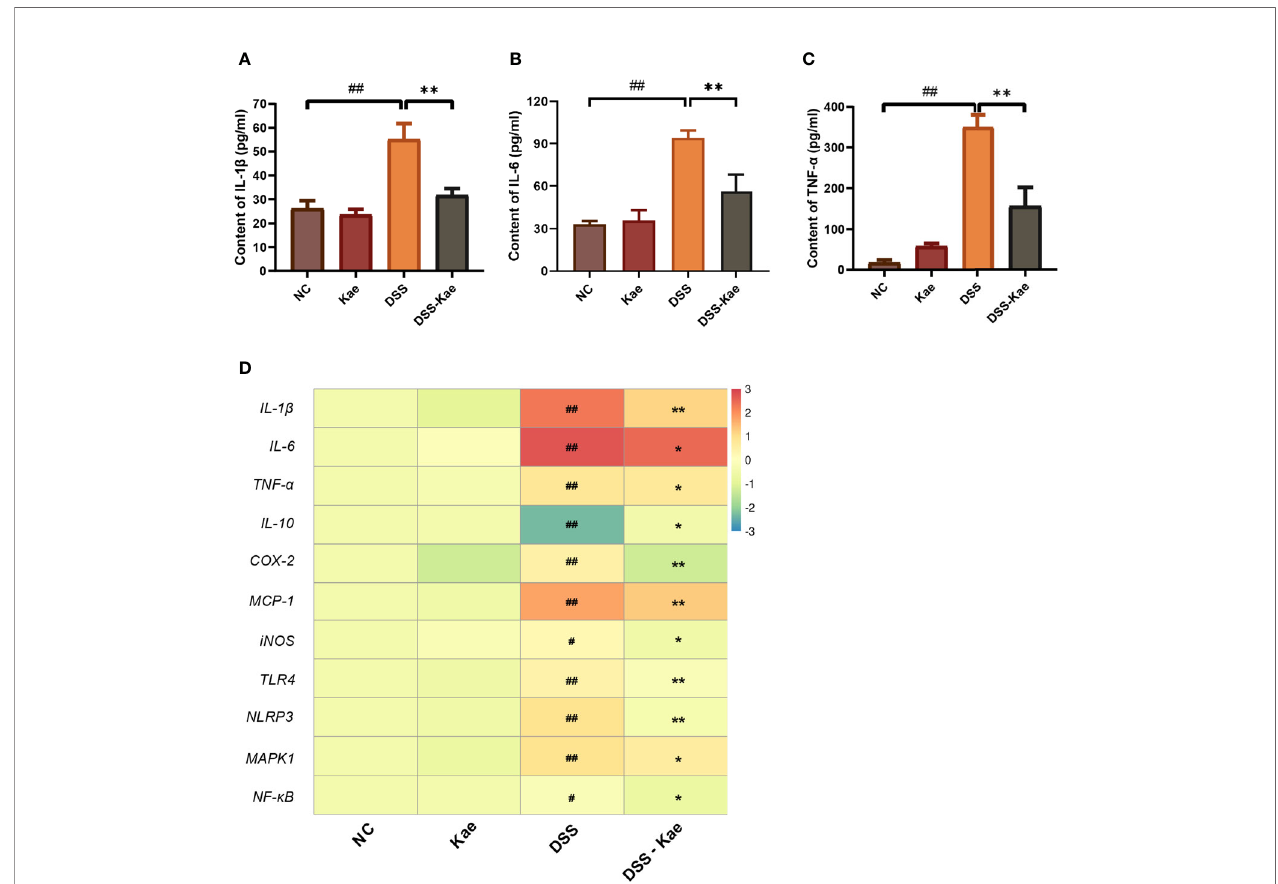
FIGURE 2 | Effects of Kae on in fl ammatory-associated cytokine levels in DSS- and Kae-treated mice. Serum in fl ammatory factors, (A) IL-1 b , (B) IL-6, and (C) TNF- a , detected using ELISA kits. (D) Relative mRNA expression of in fl ammatory factors in the colon evaluated by qRT-PCR. All data were log 2 converted and are presented as fold-change in expression level versus the NC group (means for the NC group were set as 1). Data are expressed as the mean ± SEM, n = 4 – 6, analyzed using one-way ANOVA with Tukey post-hoc analysis. DSS ( vs . NC, # P < 0.05, ## P < 0.01; vs . DSS-Kae, * P < 0.05, ** P <